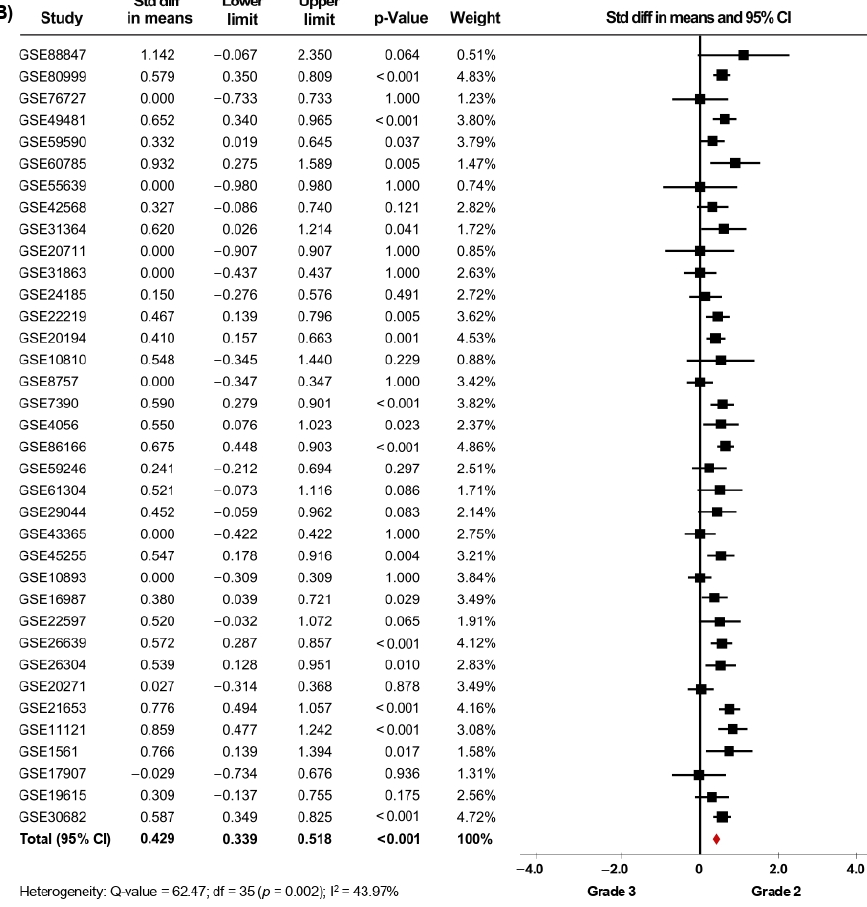
Figure 2. AR mRNA expression is significantly increased in BC patients with low histological grade. Results after sensitivity analyses. Forest plots of SMD comparing AR mRNA levels in BC patients with histological grade 3 vs. BC patients with histological grade 1 ( A ), and grade 2 ( B ). The squares represent the SMD for each dataset. The horizontal line crossing the square represents the 95% CI. The red diamonds represent the estimated overall effect.